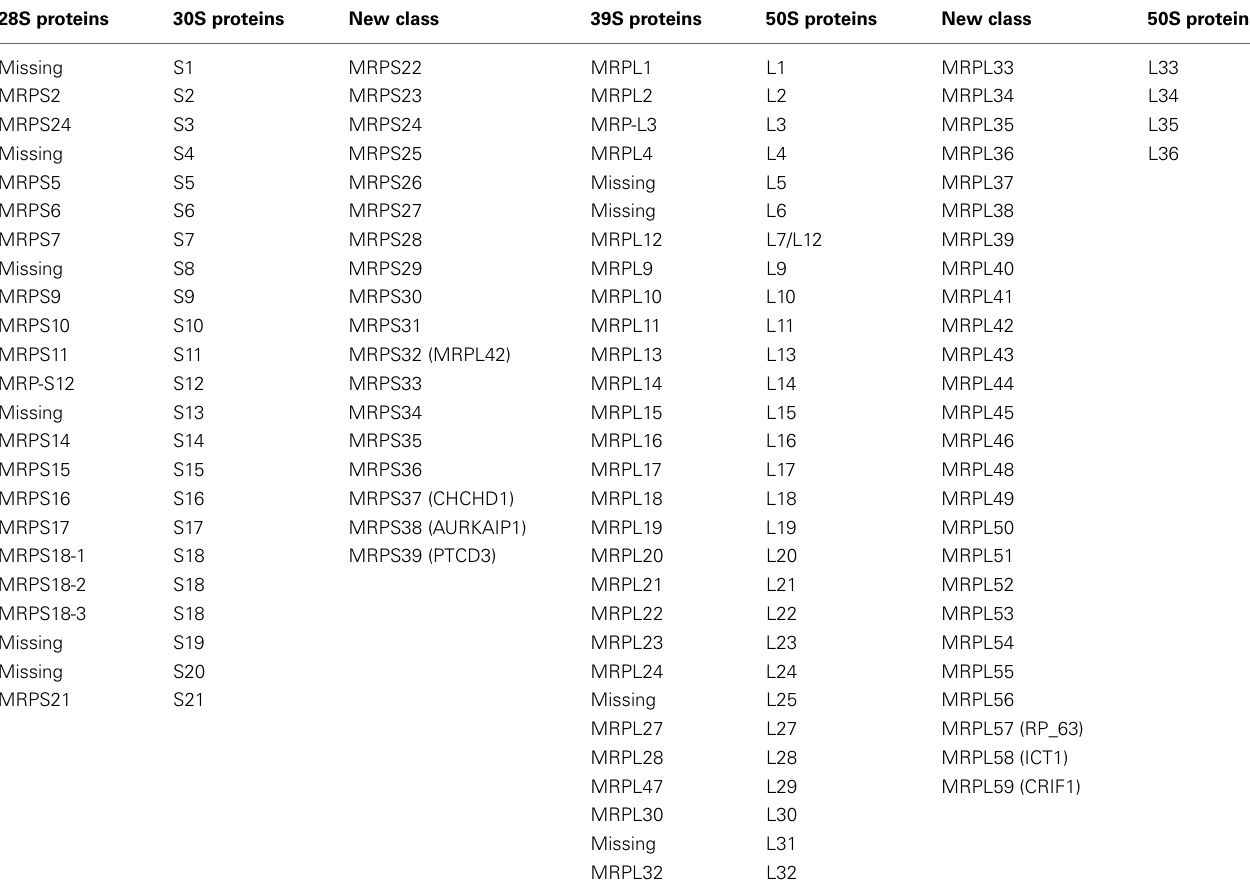
Table 4 | List of mammalian mitochondrial ribosomal proteins with their bacterial homologs. 28S